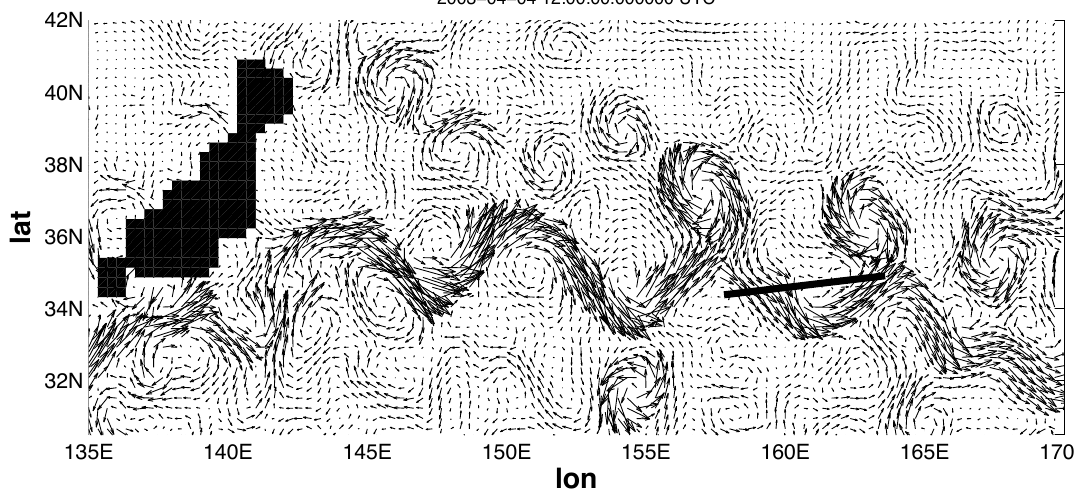
Fig. 1. Velocity field of the Kuroshio current on 4 April 2003. A line marks a piece of current across which transport is studied. Maximum values of the velocity field are about